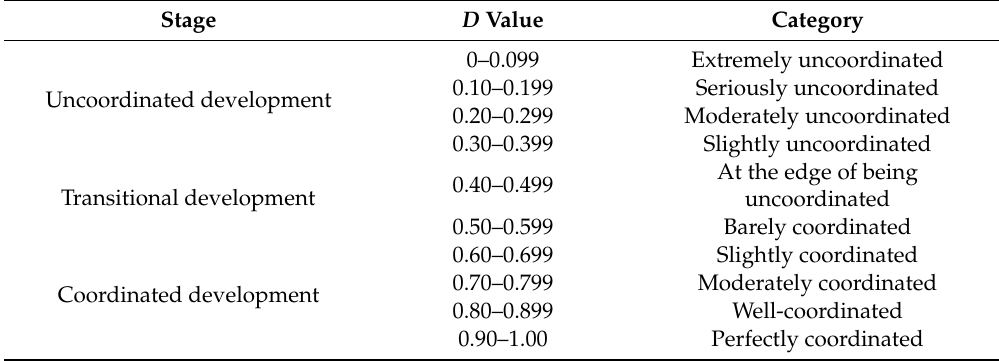
Table 3. Discriminating standards of the coupling coordination